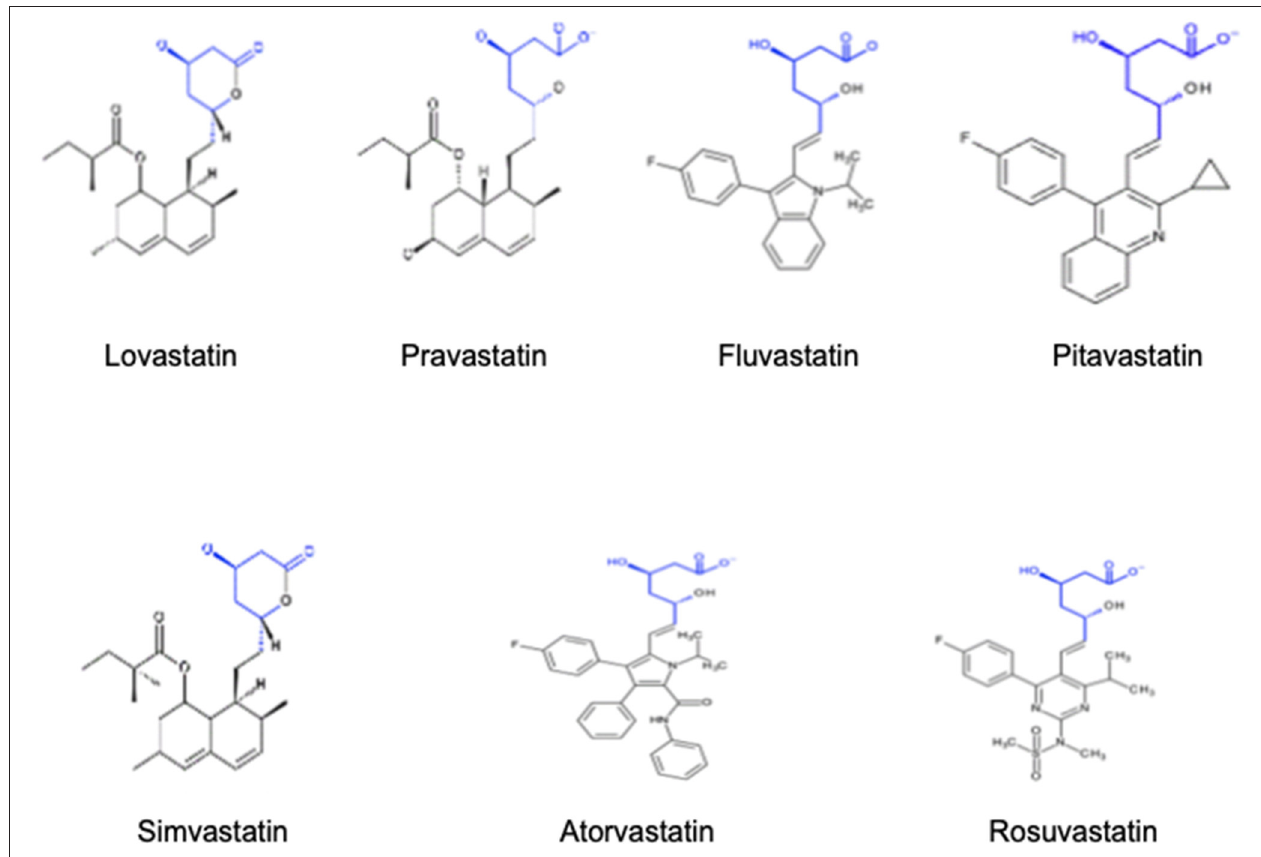
FIGURE 1 | Chemical structure of hydrophilic and lipophilic statins.